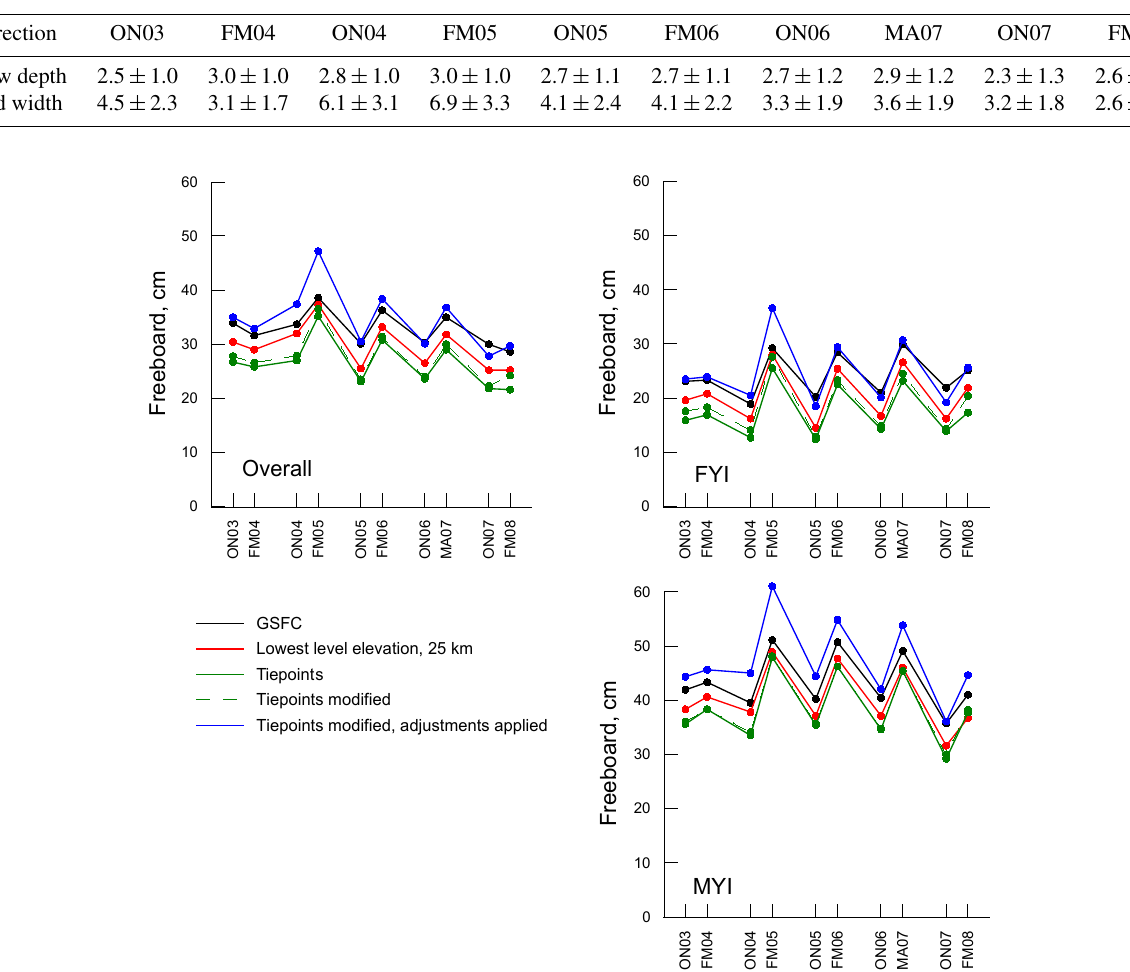
Figure 10. Freeboard time series calculated over the whole of the Arctic basin, FYI and MYI areas as provided in the GSFC product (black) and retrieved in this study by the LLE method when using shorter along-track averaging scales (red), the TP method (green), the TP method, which includes the improvements in the freeboard retrieval algorithm proposed in this study without (green dashed) or with (blue) adjustments for snow depth and lead width